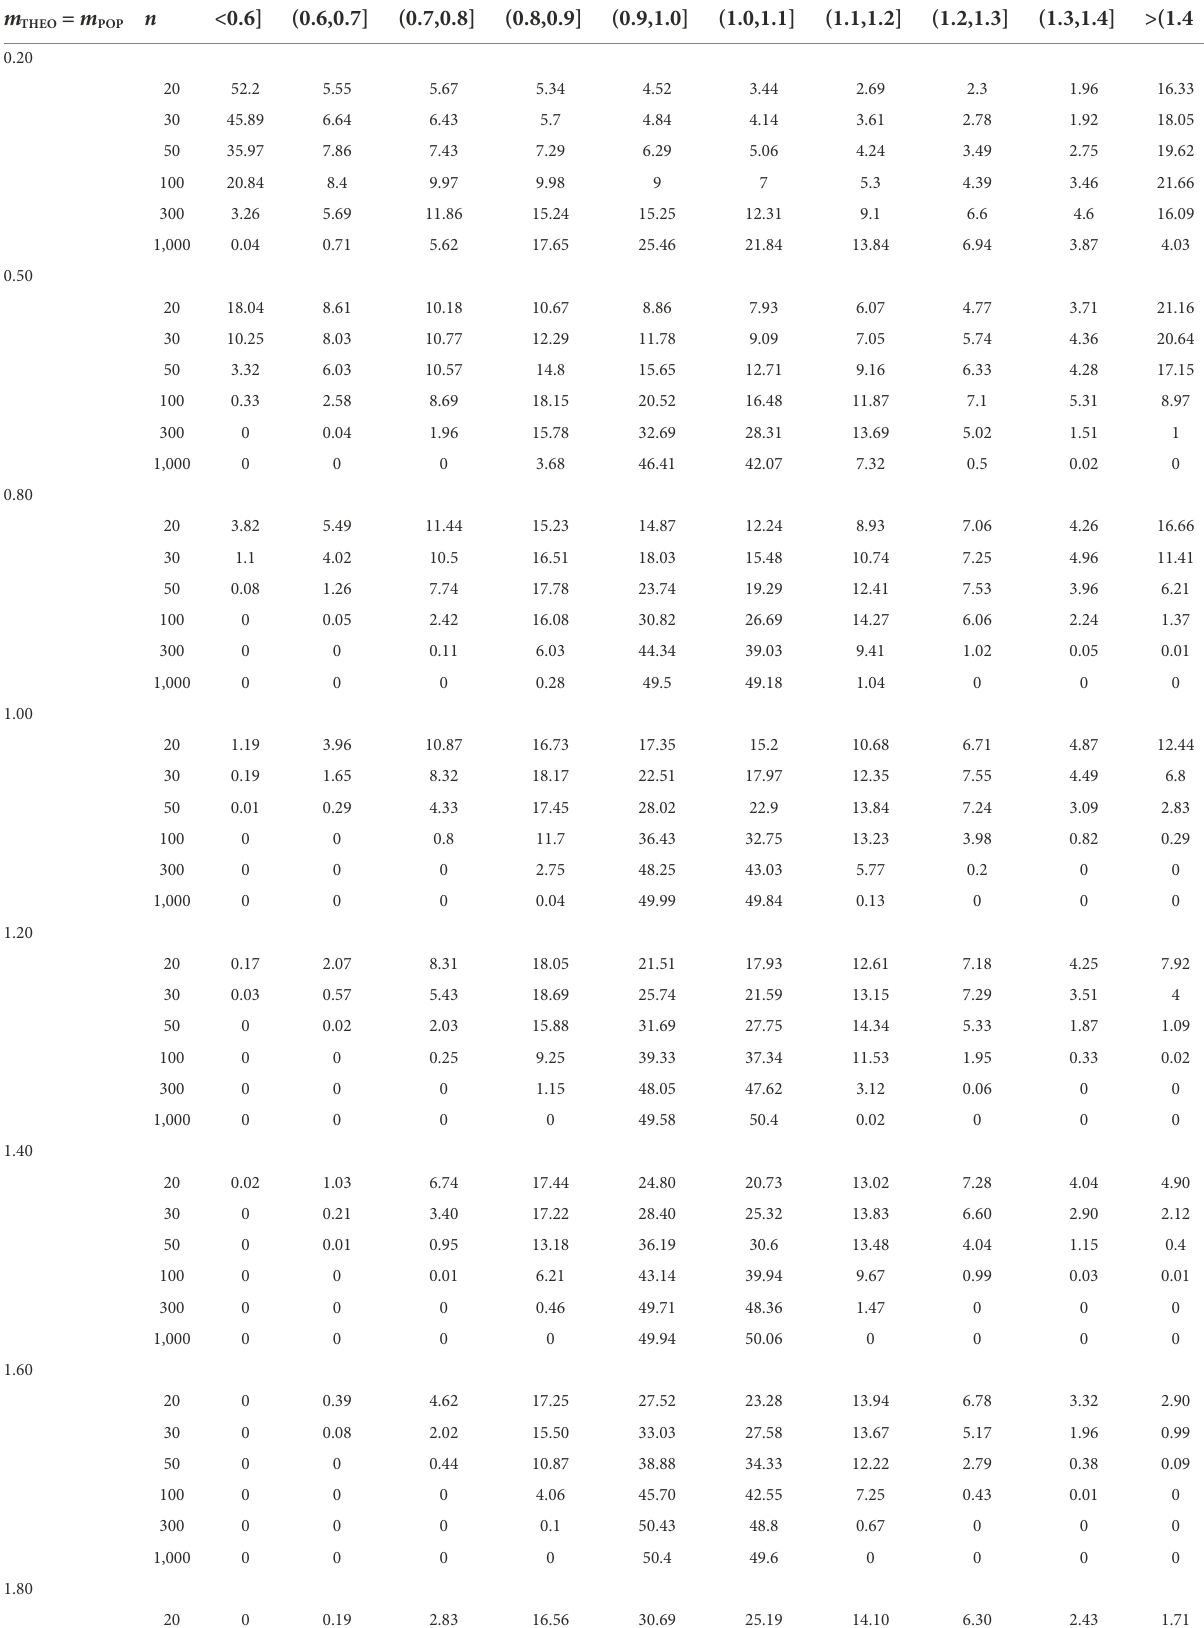
TABLE 1 True predictions [ES THEO = ES POP equals ( m THEO – m 0 ) = ( m POP – m 0 )]: expected I SIM -values for varying values of m THEO and n